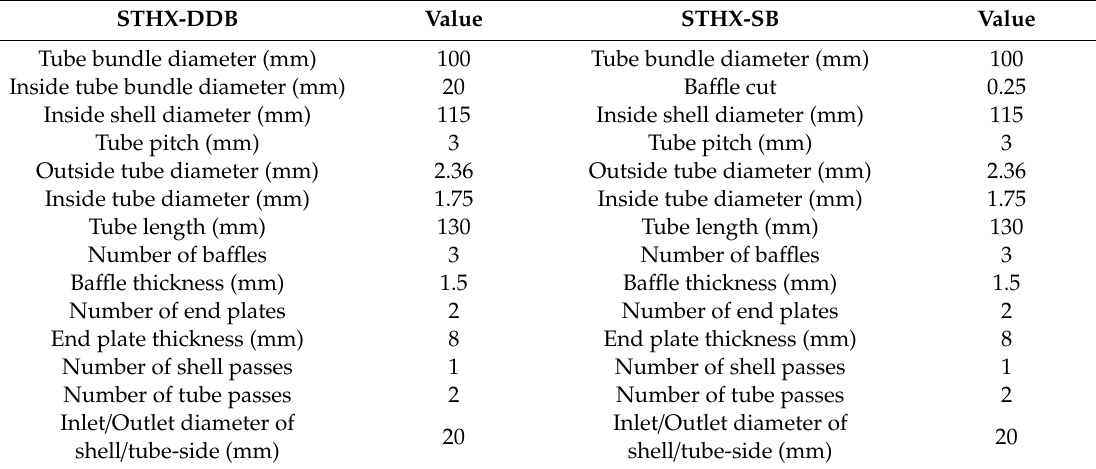
Figure 1. Di ff erences between shell-and-tube heat exchanger with disc-and-doughnut ba ffl es Figure 1. Differences between shell-and-tube heat exchanger with disc-and-doughnut baffles (STHX-DDB) and shell-and-tube heat exchanger with segmental ba ffl es (STHX-SB): ( a ) STHX-DDB; (STHX-DDB) and shell-and-tube heat exchanger with segmental baffles (STHX-SB): ( a ) STHX-DDB; ( b ) STHX-SB. ( b ) STHX-SB. Table 1. Configuration parameters of STHX-DDB and Table 1. Configuration parameters of STHX-DDB and STHX-SB.